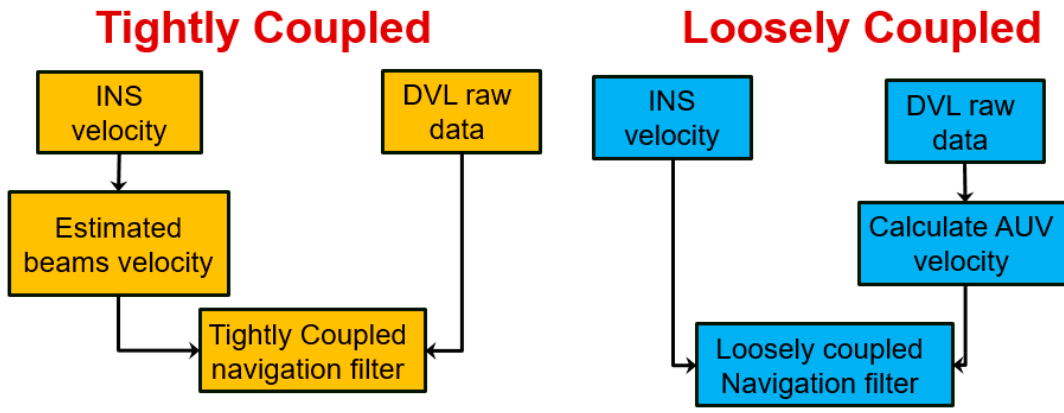
Figure 1. Scheme of loosely coupled and tightly coupled approaches for INS/DVL fusion. AUV: Autonomous underwater vehicle; DVL: Doppler velocity log; INS: inertial navigation system